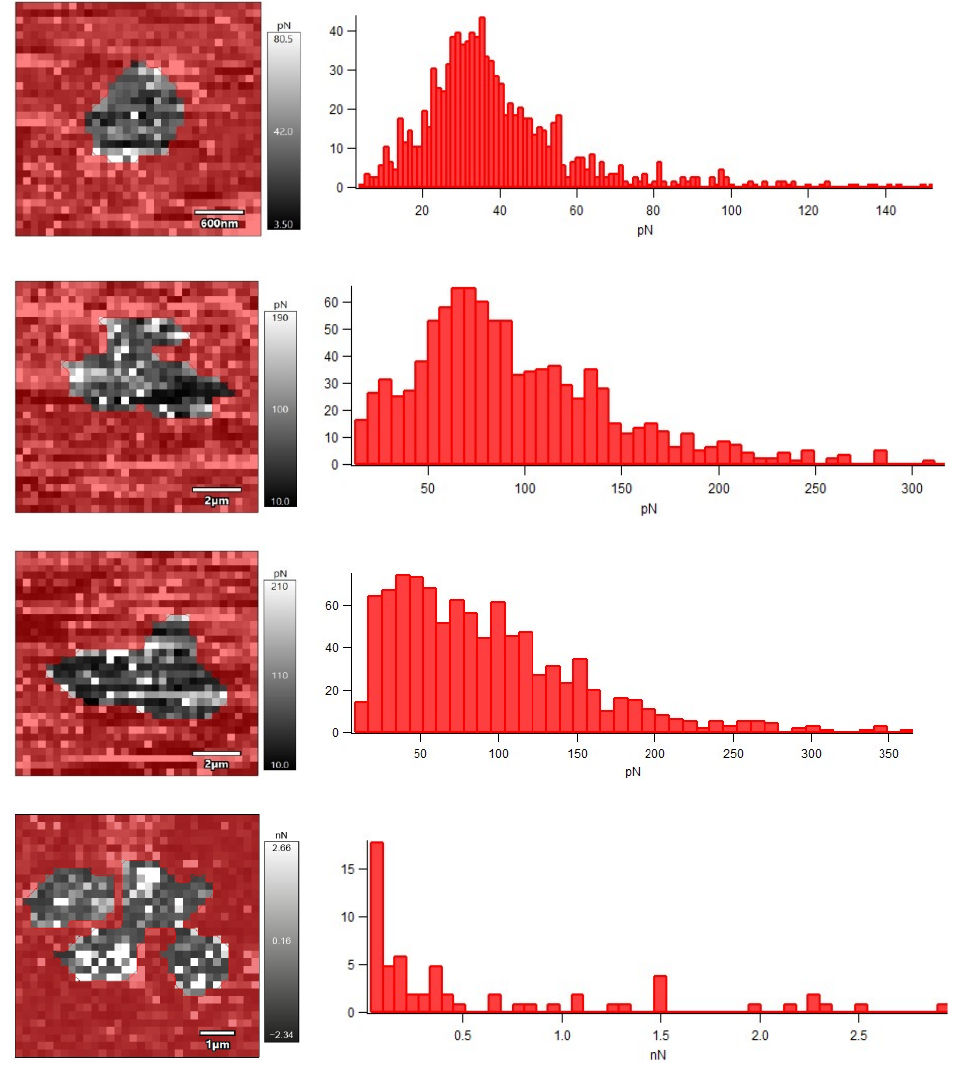
Figure 6. Force maps and histograms of the adhesion force distribution of R. ruber IEGM 231 cells incubated with Ni NPs. From top to bottom: control, 0.01, 0.1, 1.0 g/L Ni NPs.